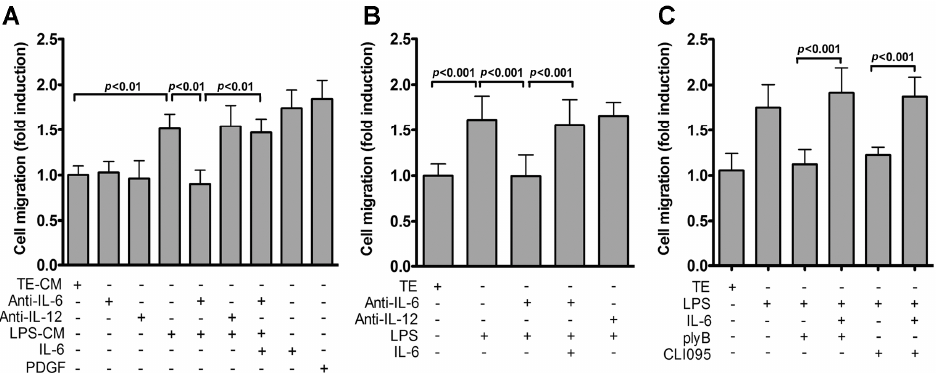
Figure 3. IL-6 mediates TLR4 signaling-induced VSMC migration. ( A ) VSMCs were treated with